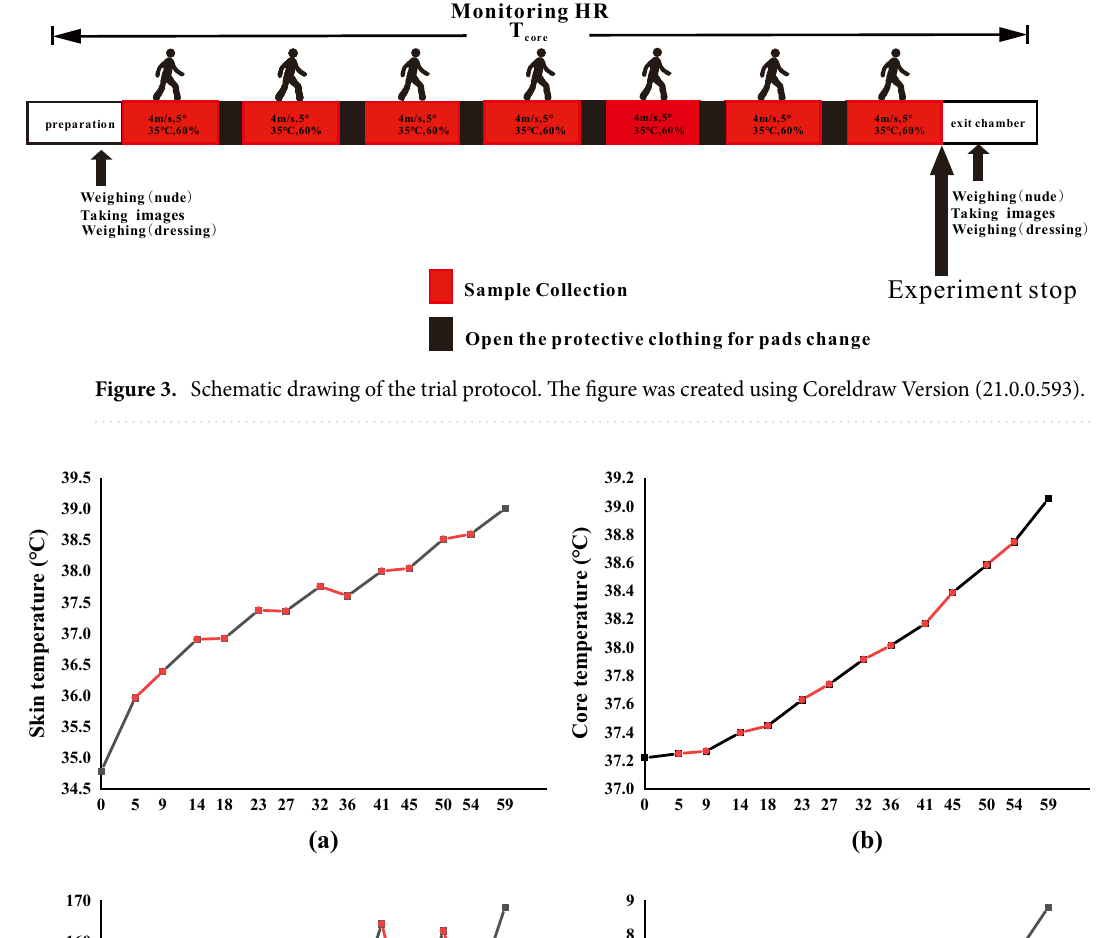
where T sk , T chest , T calf , andT arm represents mean skin temperature, chest temperature, calf temperature and arm temperature, respectively, °C. Physiological strain index ( PSI ) was calculated using Eq. (2) 24